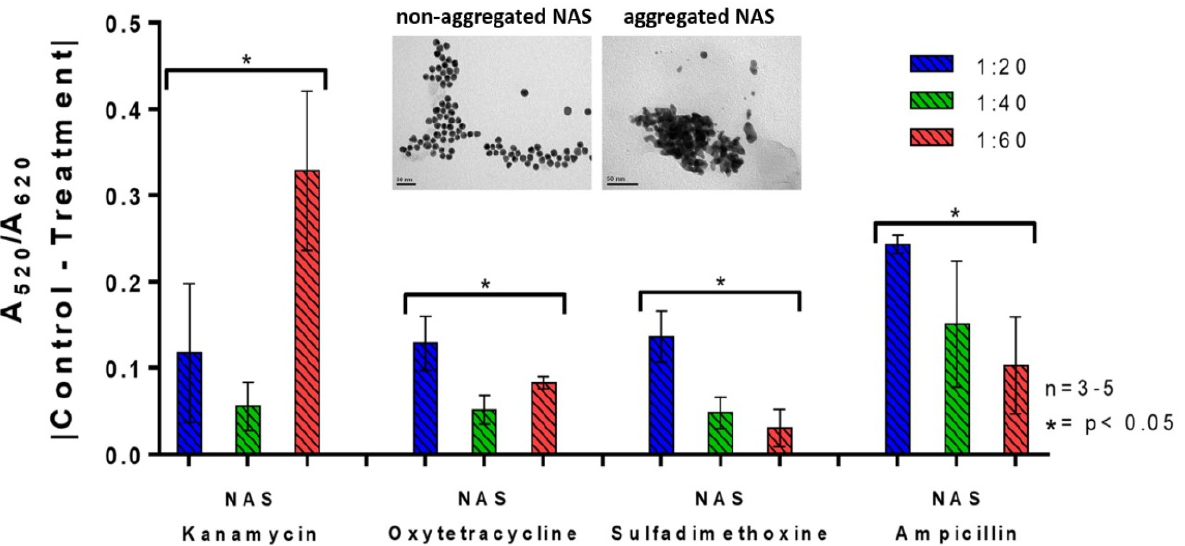
Figure 2. Colorimetric response of the NAS at molar ratios (AuNP:aptamer) of 1:20 (blue), 1:40 (green) and 1:60 (red) for the detection of antibiotics in water at their maximum concentration of residues permitted in milk (MRLs) for kanamycin, oxytetracycline, sulfadimethoxine and ampicillin. Treatments correspond to antibiotic-containing samples at the MRL concentrations and controls include nanopure water instead of antibiotics. The inset shows TEM images of dispersed NAS (before the detection of antibiotics) and aggregated NAS (after the detections of antibiotics). The ab- sorbance readings were transformed according to Equation (1). Results were averaged from 3 to 5 independent experiments. Data were analyzed using a nonparametric Mann–Whitney U test. As- terisks denote statistically significant differences between the treatments and controls. * = p < 0.05.